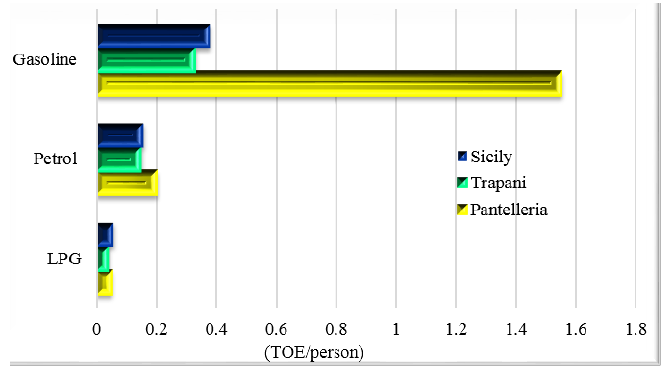
Figure 11. Comparison between the consumption of fossil fuel in Pantelleria, Province of Trapani and Sicily in 2011 [27].